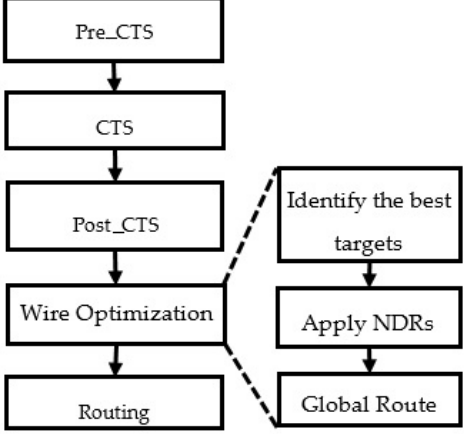
Figure 5. Baseline design flow vs. featured